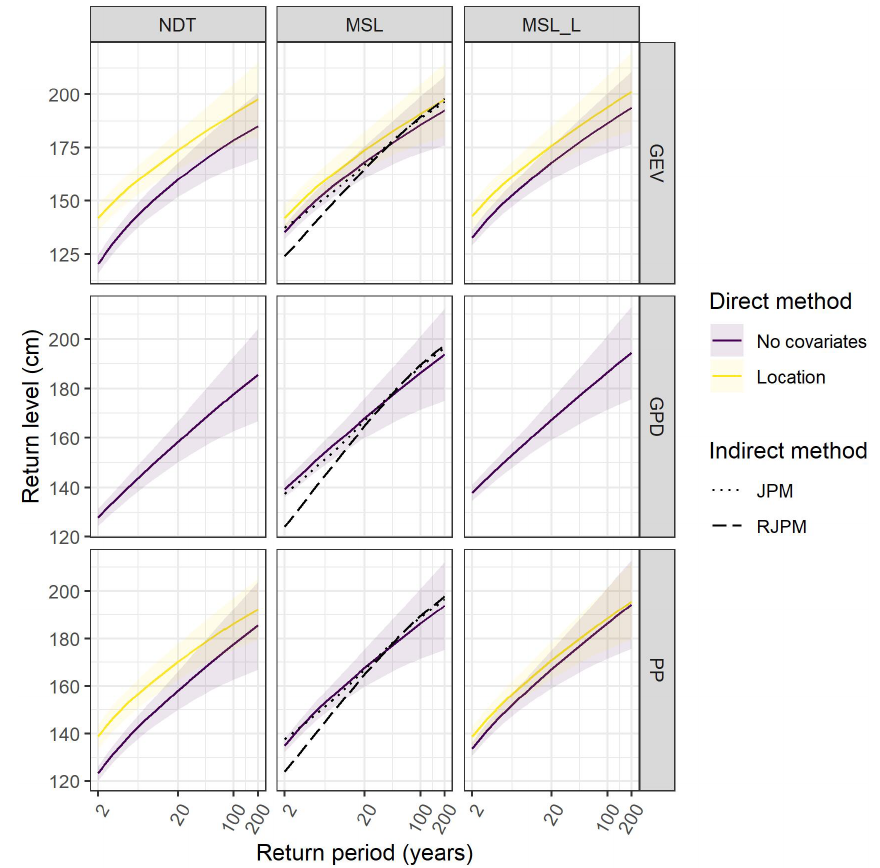
Figure 4. Return level plot actualized to 2019 for Venice. See Fig. S4 for Marseille. Plots are grouped vertically according to the detrending method (MSL: mean sea level; MSL_L: long-term mean sea level; NDT: non-detrended) and horizontally according to the distribution function (GEV: generalized extreme value; GPD: generalized Pareto distribution; PP: point process). The dashed line is the empirical return level for the joint probability method (JPM). Curves are color-coded based on the model configuration. Note the horizontal axis is logarithmic. Return level curves for direct models with covariates are reported only if the addition of the covariate improves the fit significantly ( p < 0.01; see Table